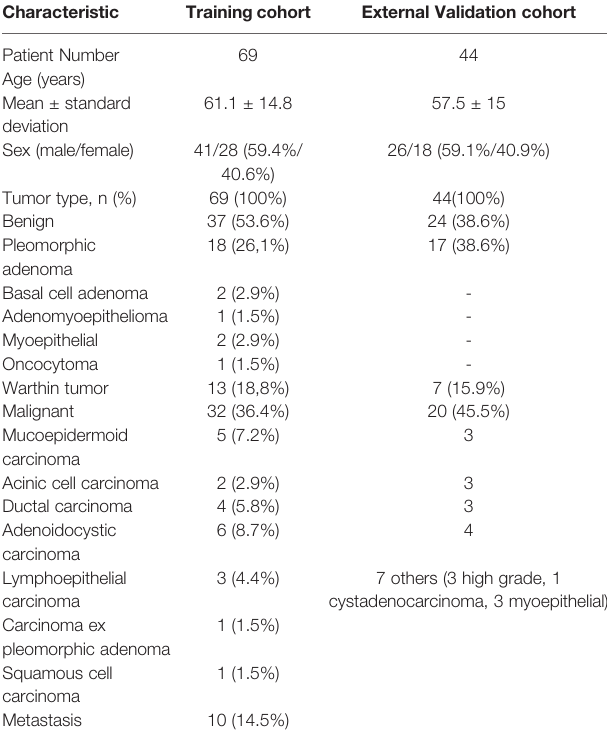
TABLE 1 | Patients ’ characteristics of training and validation